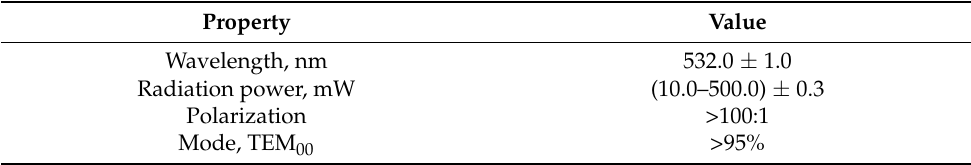
Table 1. Excitation laser parameters; laser model MGL-FN.